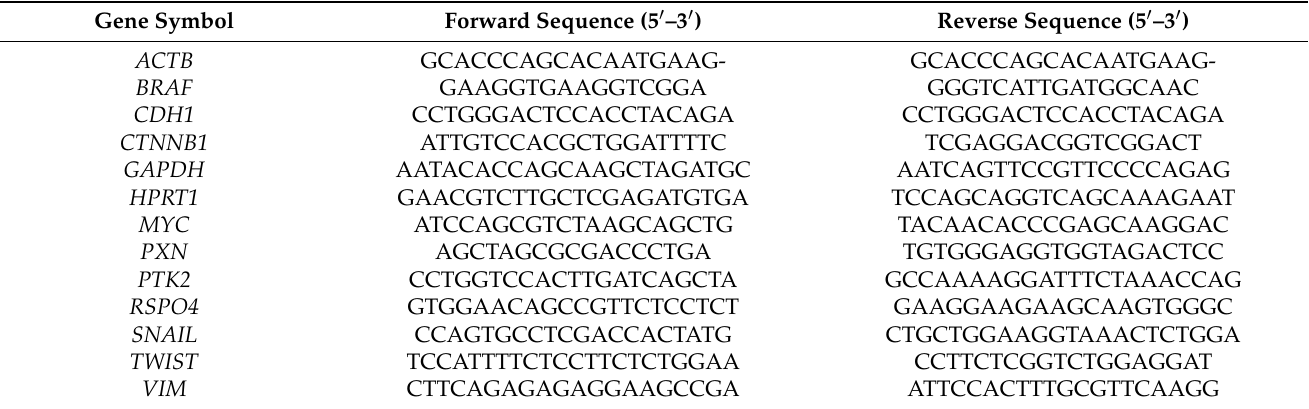
Table 3. Specific primer set sequences to evaluate and validate the gene expression in this